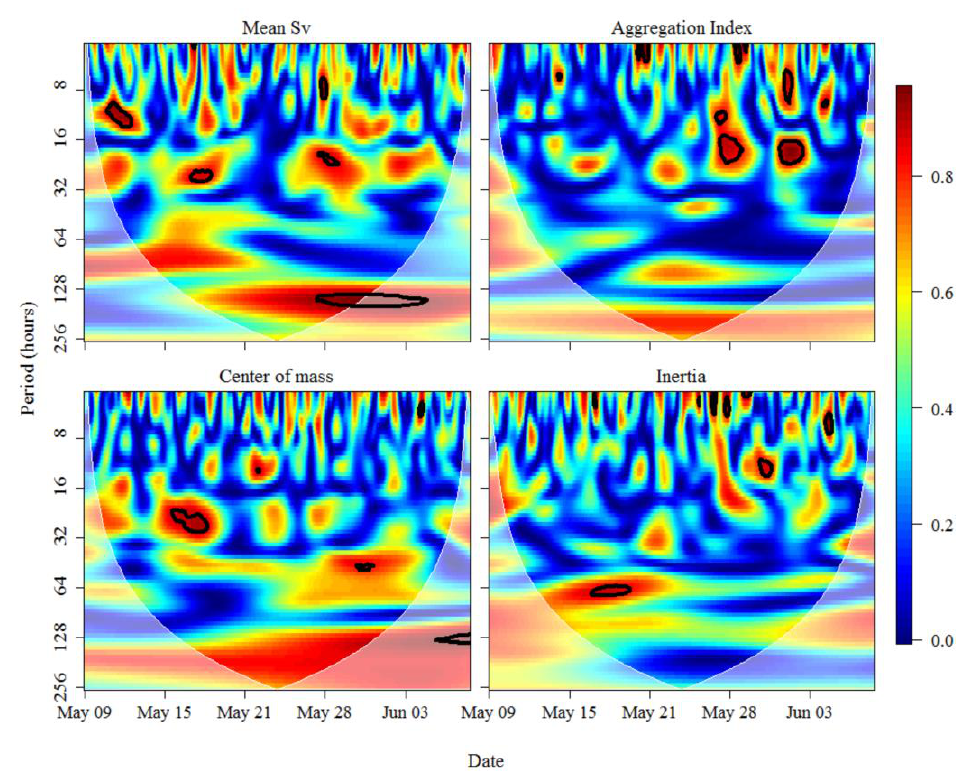
Fig. 5. Wavelet coherence in biological characteristics (Mean Sv, center of mass, inertia, and aggregation index) between the Admiralty Inlet (WA) tidal site and the PacWave energy site. Areas of significance are traced with a black line. Color bar represents